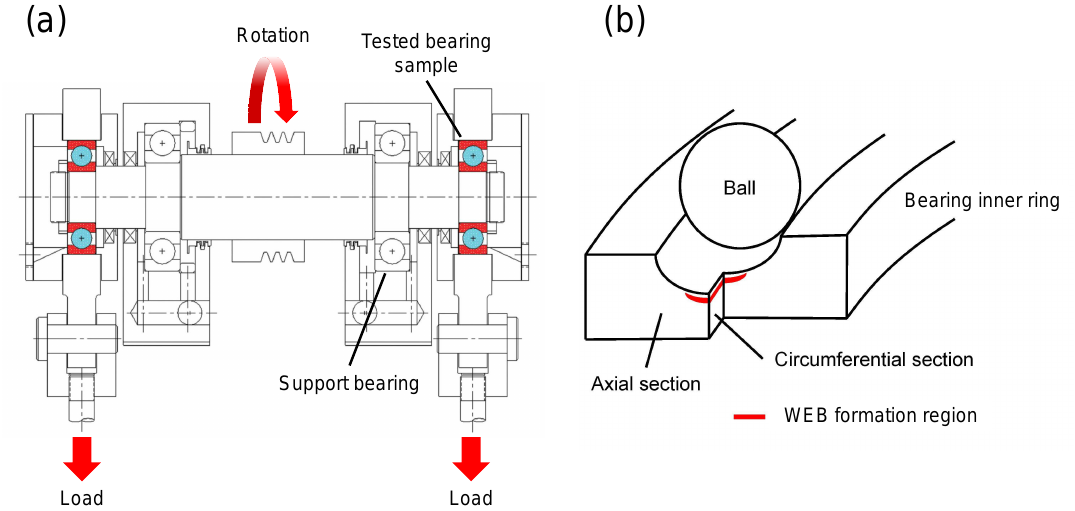
Figure 2. RCF testing. ( a ) Schematic of SKF R2 RCF test rig. ( b ) Schematic of a bearing inner ring showing where WEBs can be